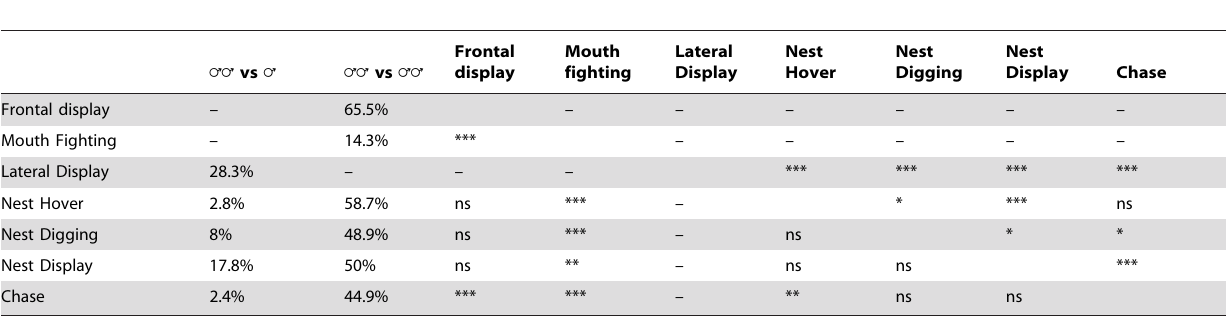
Table 4. Proportions of behavioural patterns exhibited in association with sounds in two contexts: == vs. = (1 Territorial Male x Intruders; above the diagonal) and == vs == (3 Territorial Males x Intruders; under the